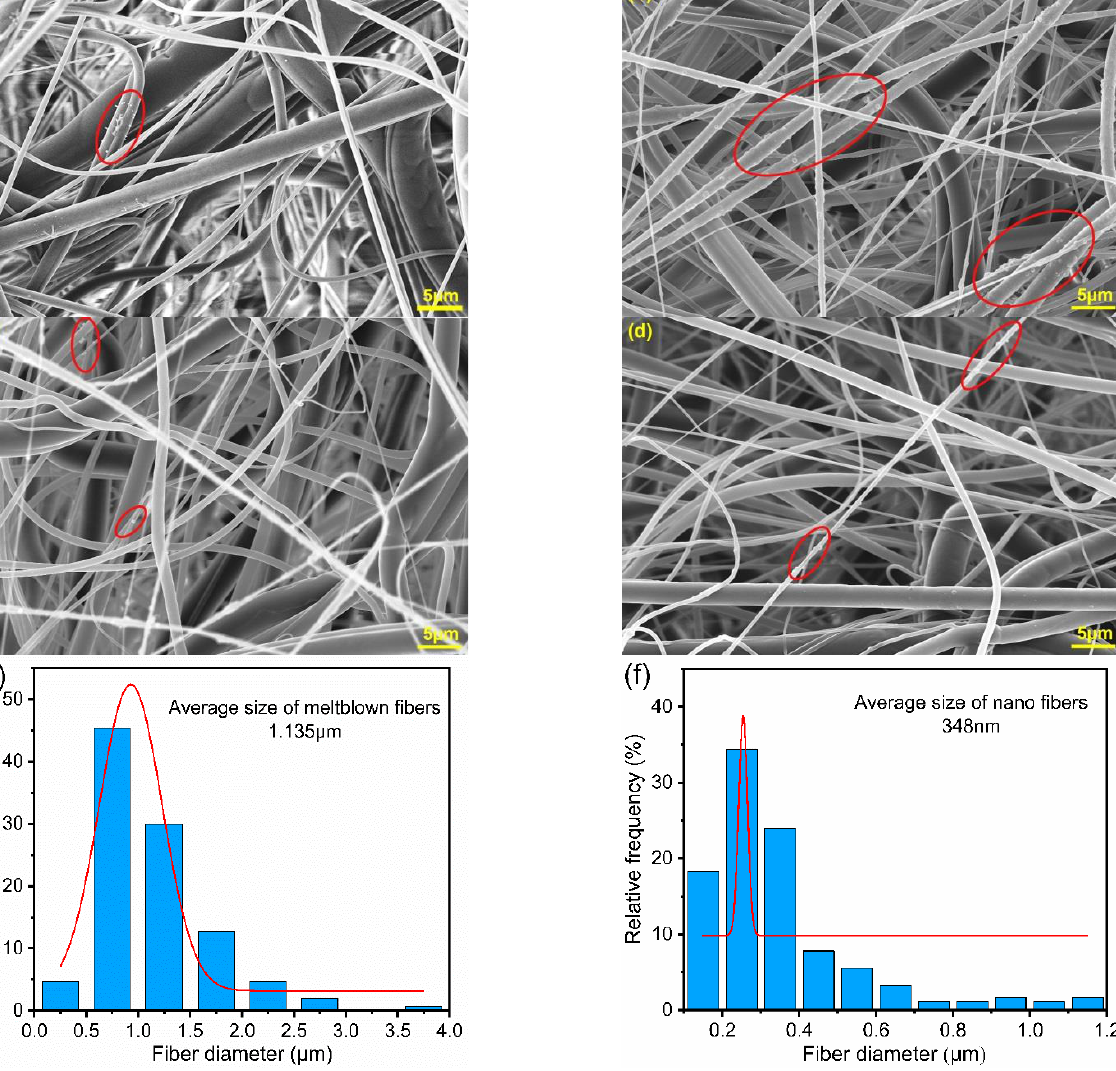
Figure 2. SEM images after filtration ( a ) bottom of pure meltblown M 1 , ( b – d ) filtrated bottom layers of M 1 E 1 *1, M 2 E 2 *3, M 3 E 3 *5, respectively. Fiber diameter distribution ( e ) meltblown microfibers, ( f ) electrospun nanofibers.